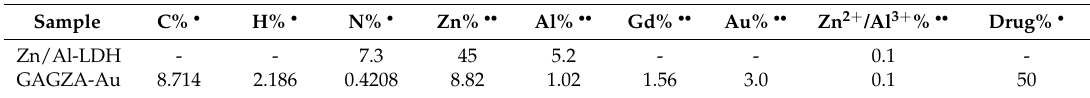
Table 3. Elemental analysis results for Zn/Al-layered double hydroxide (LDH) nanocarrier and GAGZAu